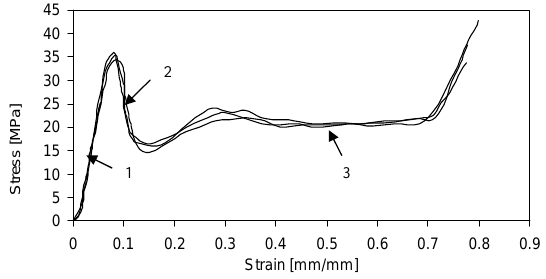
Fig. 8. Low rate out-of-plane stress-strain curves for CR-III Alu- minum honeycomb.